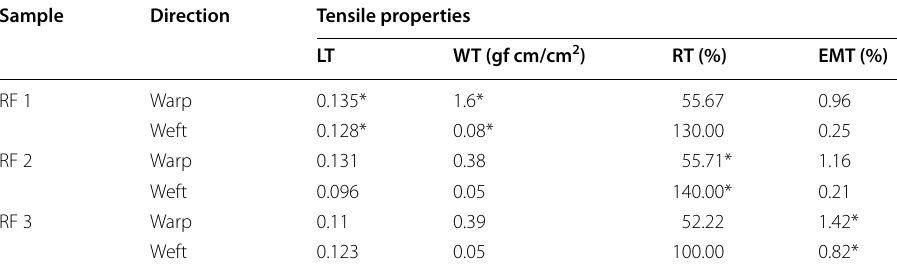
Denotes higher values in warp-wise and weft-wise directions